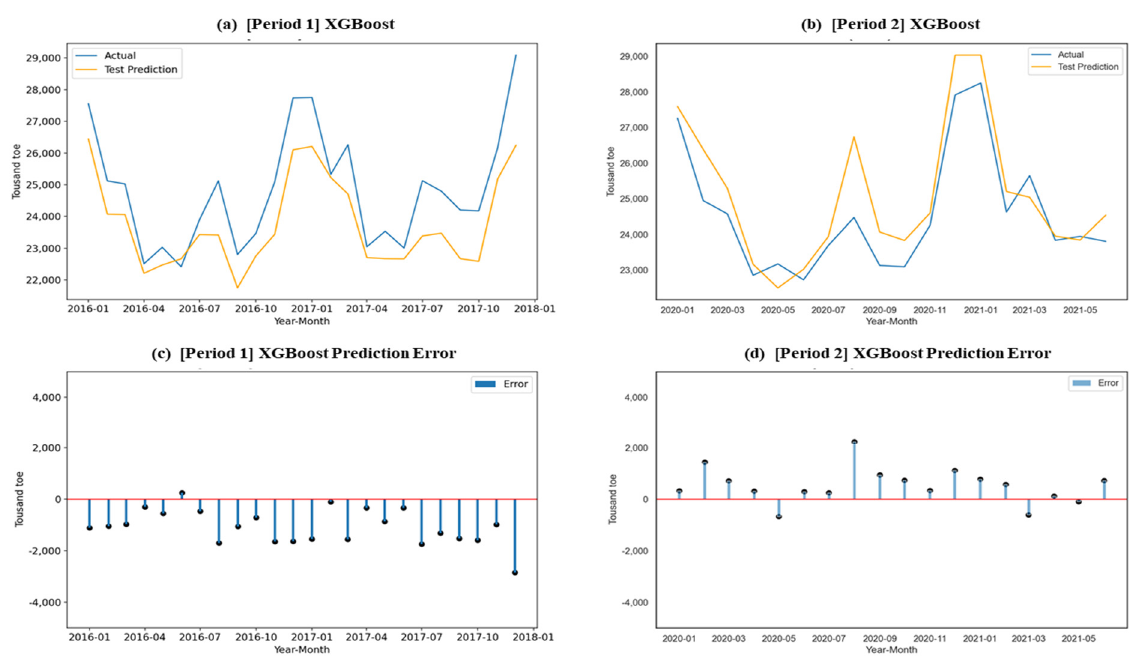
Figure 10. XGBoost model comparison by period with prediction error.